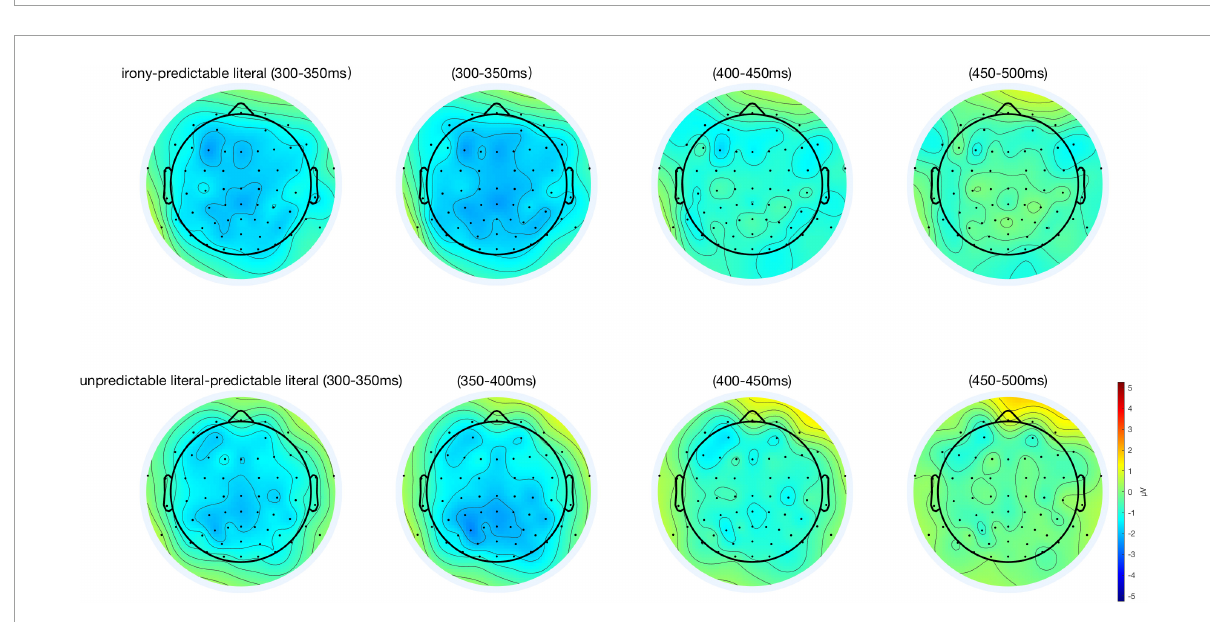
FIGURE3 The topographic maps of the scalp distribution of the N400 effect. The top row contains three topographic maps evoked by the N400 amplitude of the irony condition minus the predictable literal condition, with 50 ms intervals. The bottom row contains three topographic maps generated by the unpredictable literal conditions minus the predictable literal conditions.